Question: What visual encoding does this figure use to show its data?
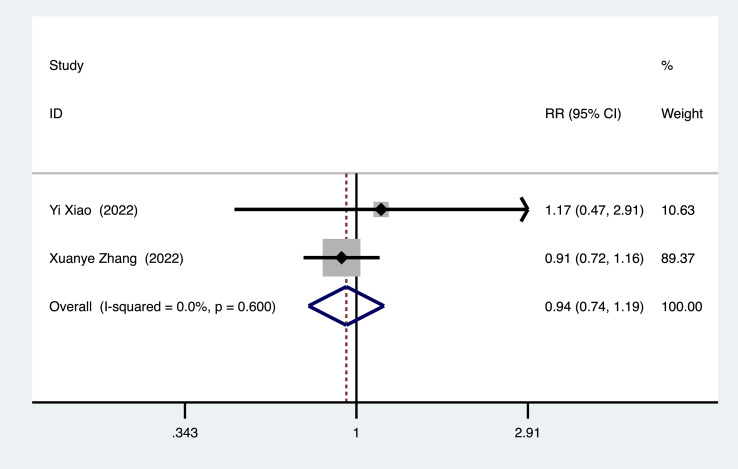
Answer: forest